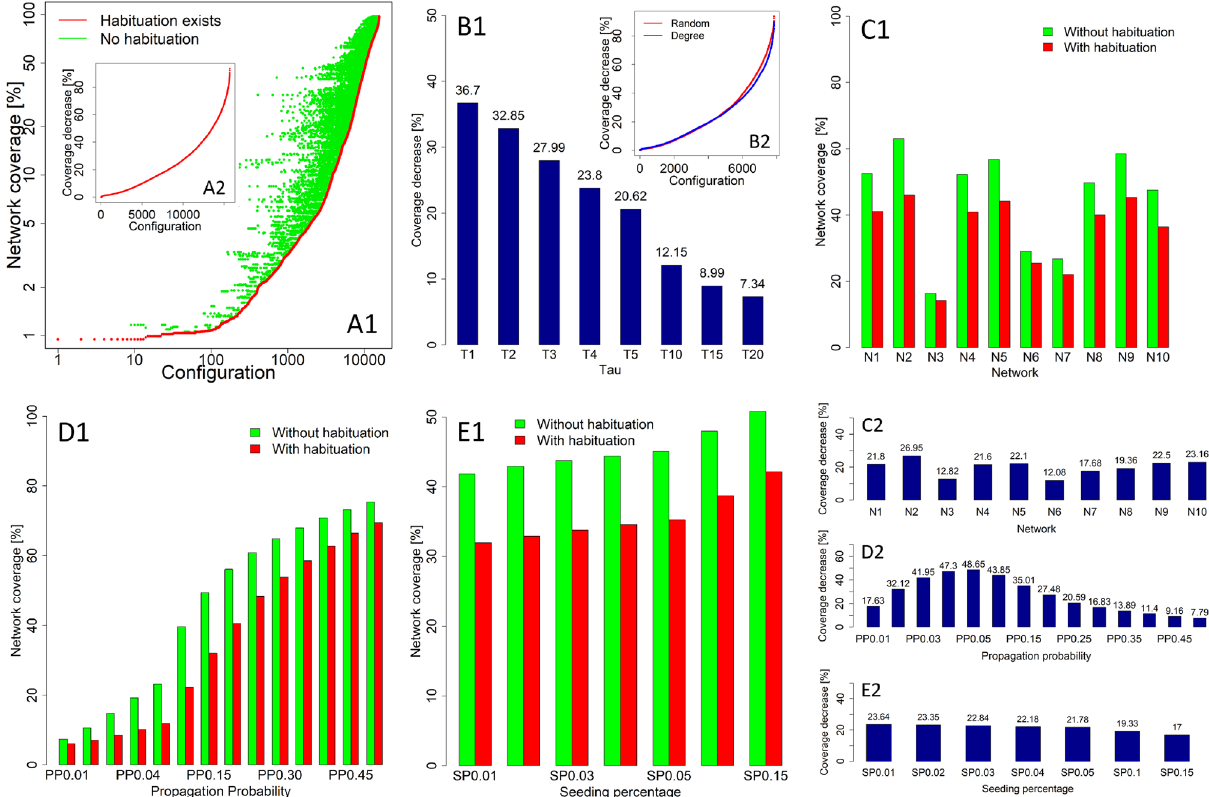
Figure 1. ( A1 ) Distances between coverage results from simulations with and without use of the habituation effect, with results sorted by coverage without habituation and assigned corresponding results modelled with use of the habituation effect. ( A2 ) Coverage decrease in processes with the habituation effect, compared to without habituation, sorted by coverage decrease. ( B1 ) Effect of the τ parameter on coverage decrease. ( B2 ) Coverage decrease for random and degree-based seed selection. ( C1 ) Network coverage for spreading processes with and without habituation for Networks N1–N10. ( C2 ) Coverage decrease for Networks N1–N10 with habituation effect considered. ( D1 ) Coverage for spreading processes with and without habituation, with propagation probabilities ranging from 0.01 to 0.50. ( D2 ) Coverage decrease for used propagation probabilities with habituation effect considered. ( E1 ) Network coverage for spreading processes with and without habituation, with seeding percentage ranging from 0.01 to 0.15%. ( E2 ) Average decrease for used seeding percentages with habituation effect taken into